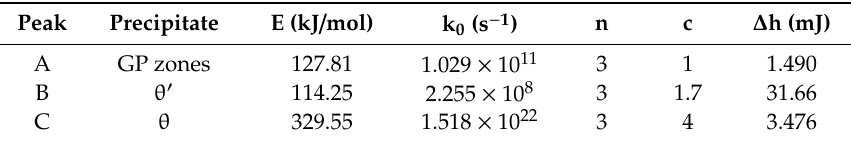
Table 5. Parameters from the fitting procedure for the binary Al-3.5 wt%Cu alloy, data from [22].